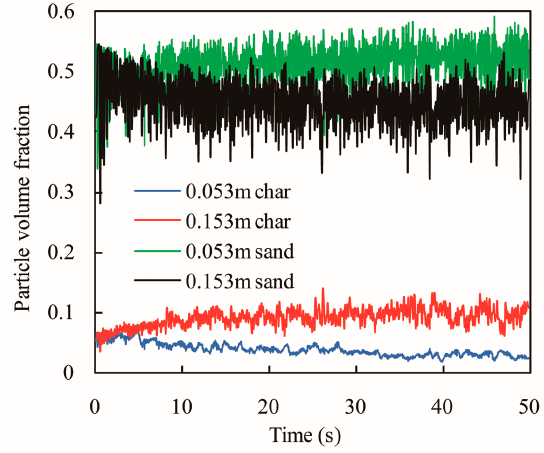
Figure 3. Time profiles of the particle volume fraction in different layers along the height direction.